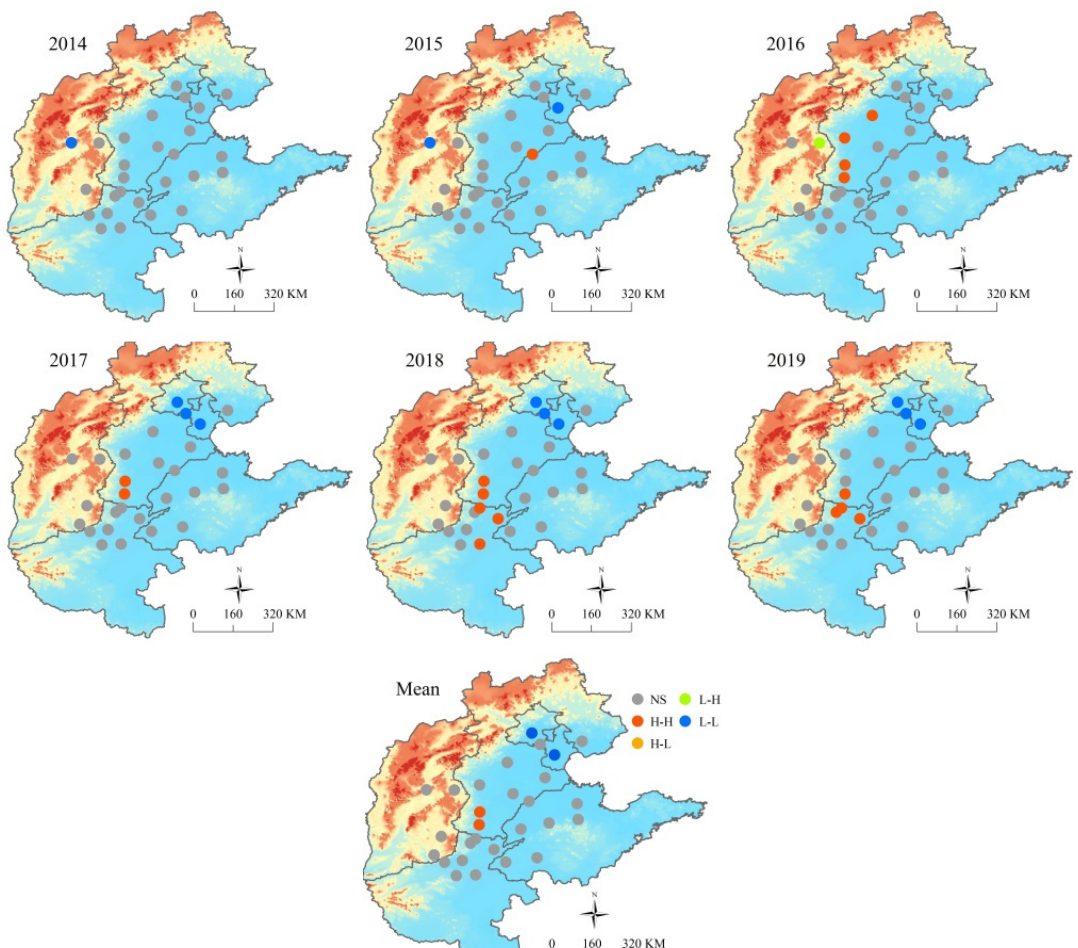
Figure 3. Local spatial autocorrelation features of mean PM 2.5 concentrations in winter among the 28 air transport channel cities from 2014 to 2019: H–H, city and surrounding cities have high PM 2.5 concentrations; H–L, city has a high PM 2.5 concentration, but those of surrounding cities are low; L–H, city has a low PM 2.5 concentration, but those of surrounding cities are high; L–L, both the city and surrounding cities have low PM 2.5 concentrations; NS, no significant difference in PM 2.5 con- centration among cities.